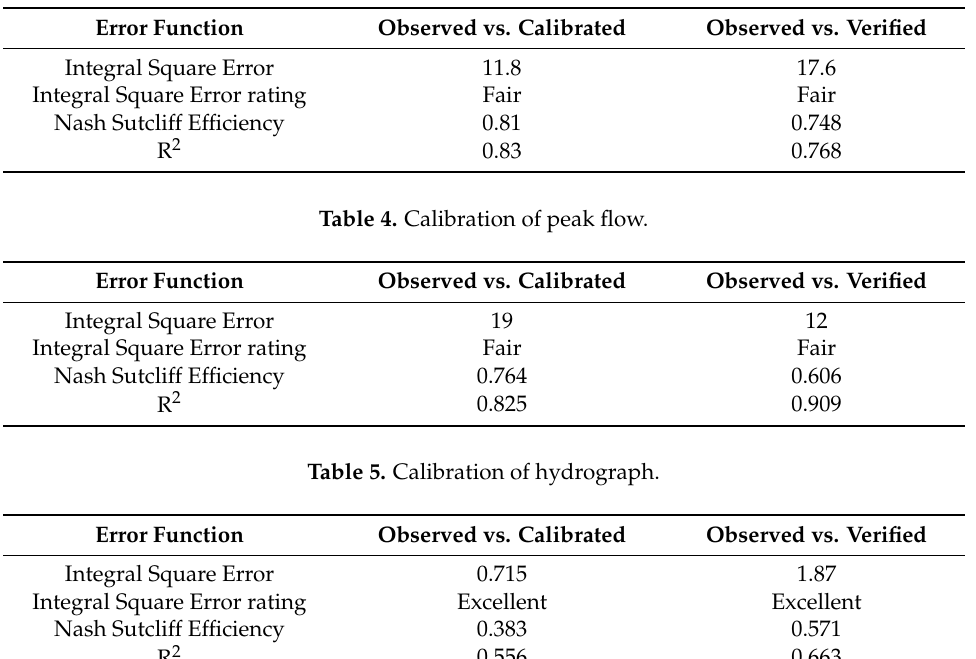
Table 3. Calibration of total runoff.